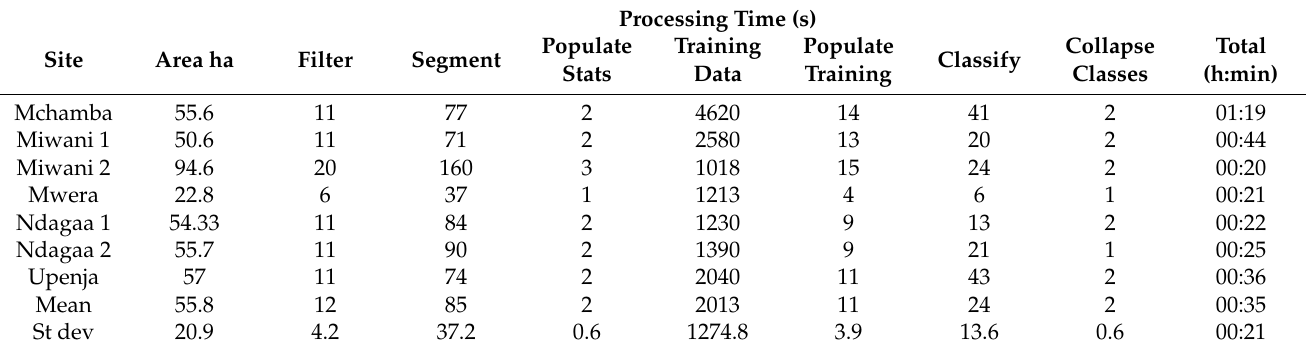
Table 3. Summary of each step in the supervised classification procedure with associated processing time.